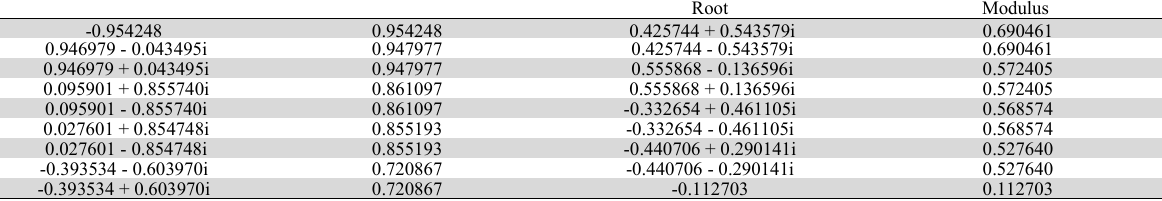
Testing the stability of the model